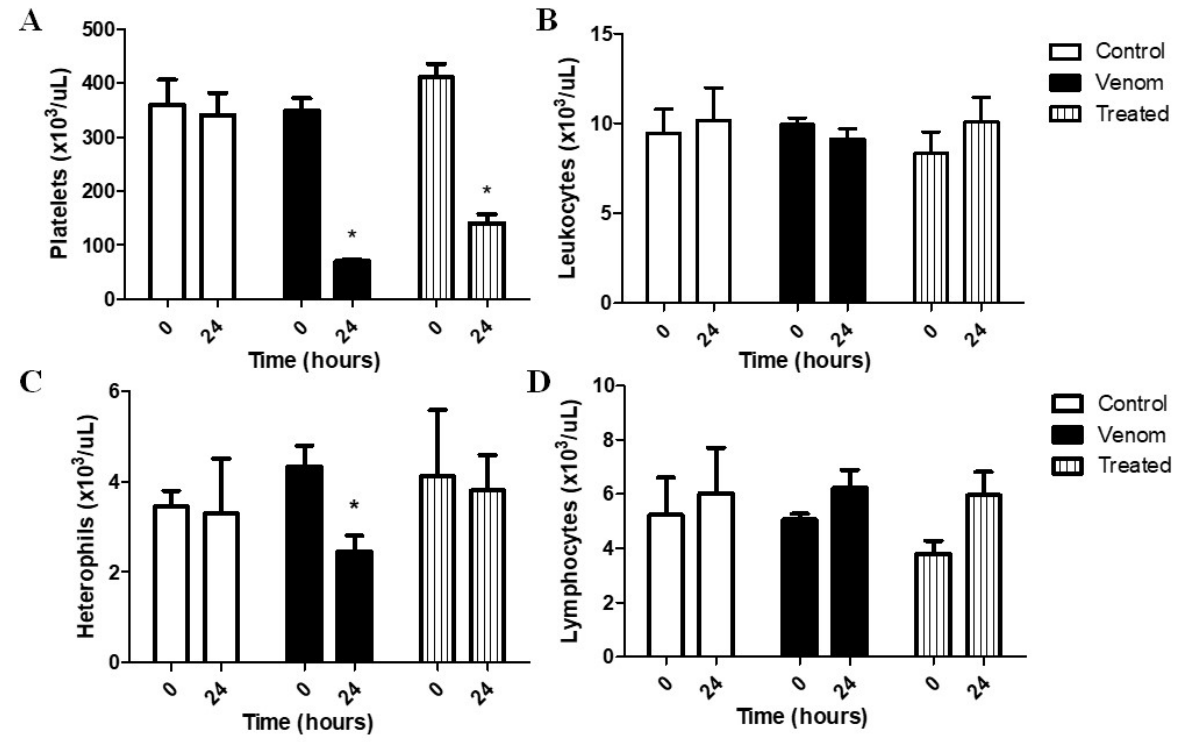
Figure 1. Effect of treatment with copaiba oil after Loxosceles intermedia venom injection on blood cells. Platelets (a) and heterophils (c) count showed significant reduction after venom injection (4,8 μg/kg). The treatment was efficient in inhibiting the decrease of heterophils in the blood 24 hours after venom inoculation *p <0.05 / ANOVA. However, groups inoculated with venom and treated with copaíba oil showed no significant difference from the control group at total leukocyte (b) and lymphocyte count (d) . n = 4 animals per experimental